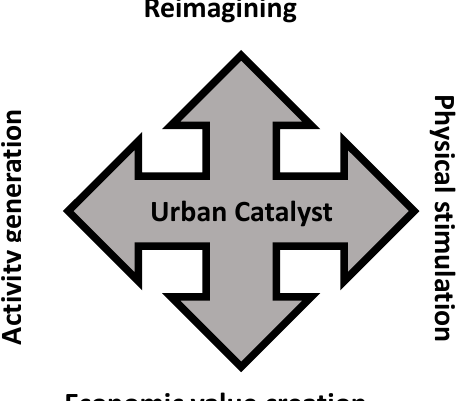
Figure 1. Four dimensions of influencing urban